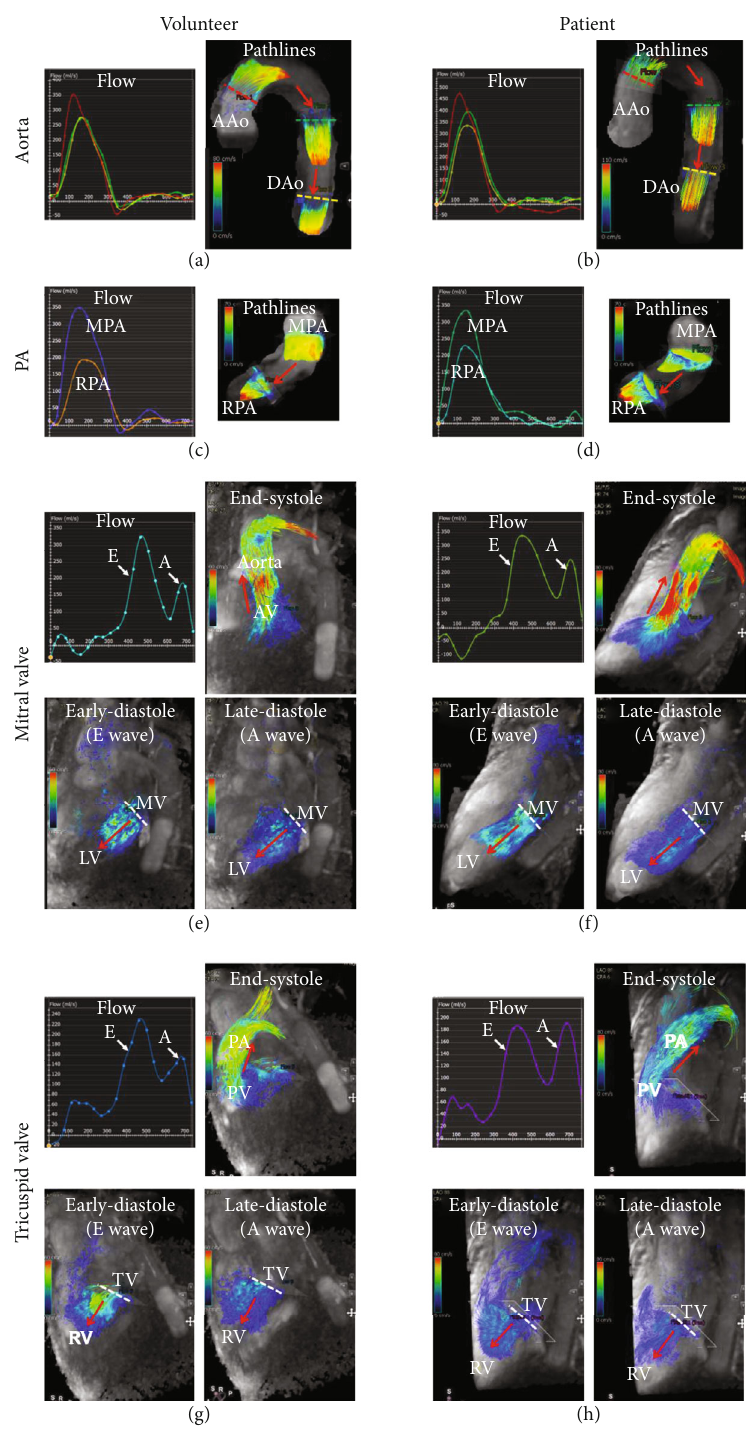
Figure 6: Comparison between volunteer (a, c, e, g) and patient (b, d, f, h) fl ow dynamics in the aorta (a, b), pulmonary artery (c, d), mitral valve (e, f), and tricuspid valve (g, h). The fi gure shows di ff erent patterns of fl ow curves and hemodynamics between the volunteer and patient; for example, the early-to-atrial (E/A) fi lling ratios in the mitral and tricuspid valves are lower in patient compared to volunteer, which may re fl ect diastolic dysfunction. Flow directions are shown by red arrows. 4D- fl ow videos in patient and volunteer are provided in supplementary materials (available here). AAo: ascending aorta; DAo: descending aorta; PA: pulmonary artery; MPA: main pulmonary artery; RPA: right pulmonary artery; LV: left ventricle; RV: right ventricle; AV: aortic valve; PV: pulmonary valve; MV: mistral valve; TV: tricuspid